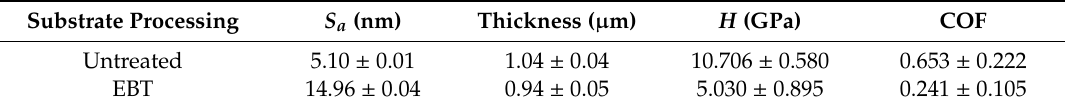
Figure 4. Atomic force microscopy (AFM) 2D and 3D images of TiN / TiO 2 coating deposited on Co–Cr substrate: ( a ) 3D micrograph of treated substrate; ( b ) 2D micrograph of treated substrate; ( c ) 3D micrograph of untreated substrate; ( d ) 2D micrograph of untreated substrate. Table 2. The parameters characterizing the surface topography ( S a ), thickness, hardness ( H ), and coe ffi cient of friction (COF) of the investigated